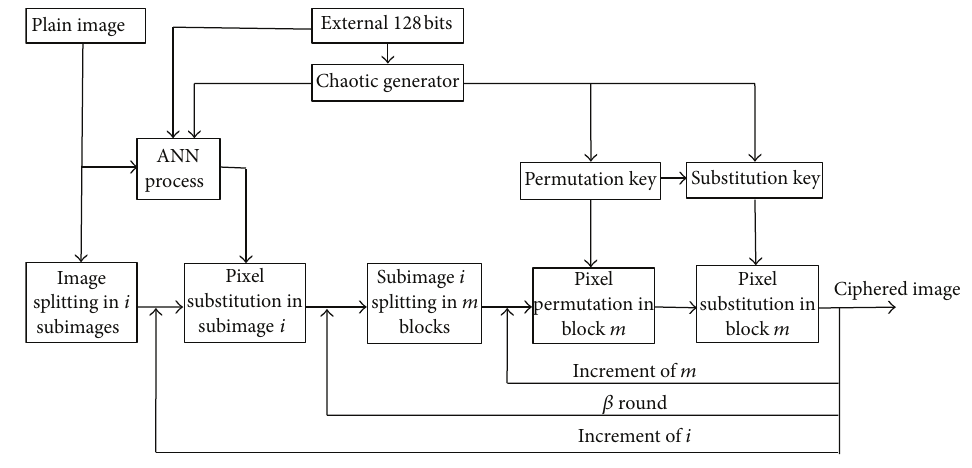
Figure 1: Block diagram of the proposed scheme.